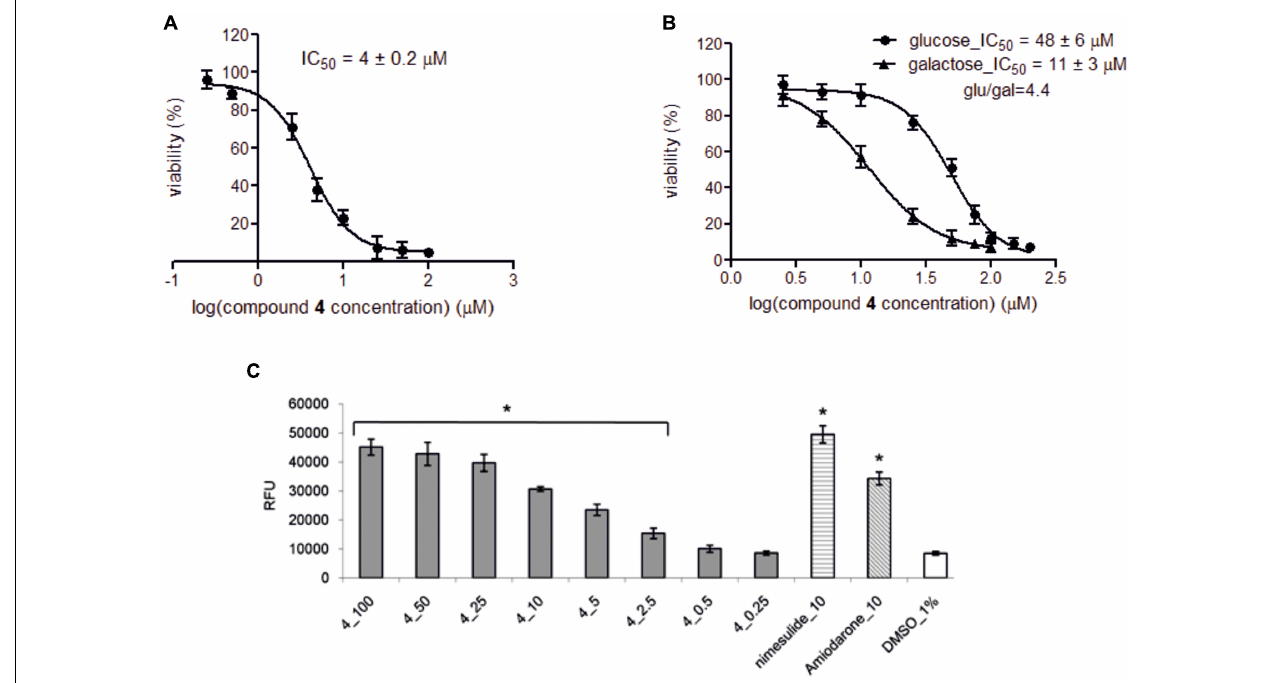
FIGURE 6 | The effect of compound 4 on HepG2 viability and concentration-dependent effect of compound 4 and comparators on ROS level. (A) Hepatotoxicity provoked by compound 4 was assessed after 72 h incubation of HepG2 cells in low glucose medium (5 mM) in the presence of compound 4 (0.25–100 µ M). (B) Mitochondrial toxicity was determined after 24 h incubation of HepG2 cells in either high glucose medium (25 mM) or galactose medium (10 mM) in the presence of compound 4 (2.5–150 µ M). Cell viabilities were recorded in triplicates in three independent experiments and expressed as percentage of vehicle control ± SD and IC 50 values were determined by GraphPad Prism software using following equation: Y = Bottom + (Top–Bottom)/(1 + 10ˆ((LogIC 50 -X) ∗ HillSlope)), where IC 50 is the concentration of compound 4 that inhibits cell viability half way between Bottom and Top plateaus, X is compound 4 concentration and HillSlope describes the steepness of the family of curves. Glu/gal index higher than 3 indicates potential mitochondrial toxicity of compound. (C) Concentration-dependent effect on ROS level. HepG2 cells were treated with compound 4 (0.25–100 µ M) for 72 h, and then the intracellular level of total ROS in relative fluorescence units (RFU) was detected. The data are presented as the mean ± SD for at least three independent experiments and each experiment was carried out in triplicate. Final concentration of DMSO in samples was 1%. Samples treated only with CM-H2DCFDA and 1% DMSO served as negative control, nimesulide and amiodarone (10 µ M) serve as positive control. Single asterisks ( ∗ ) indicate a significant difference ( P < 0.05) compared to 1% DMSO control (one-way ANOVA with Dunnett’s